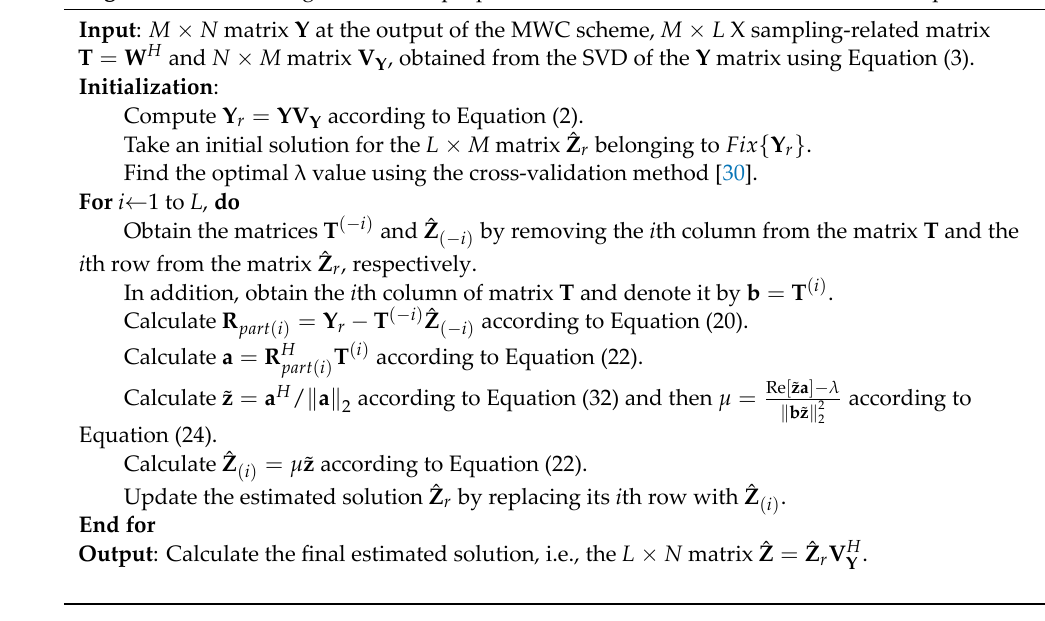
Algorithm 1 Processing flow for the proposed data reduction invariant LASSO